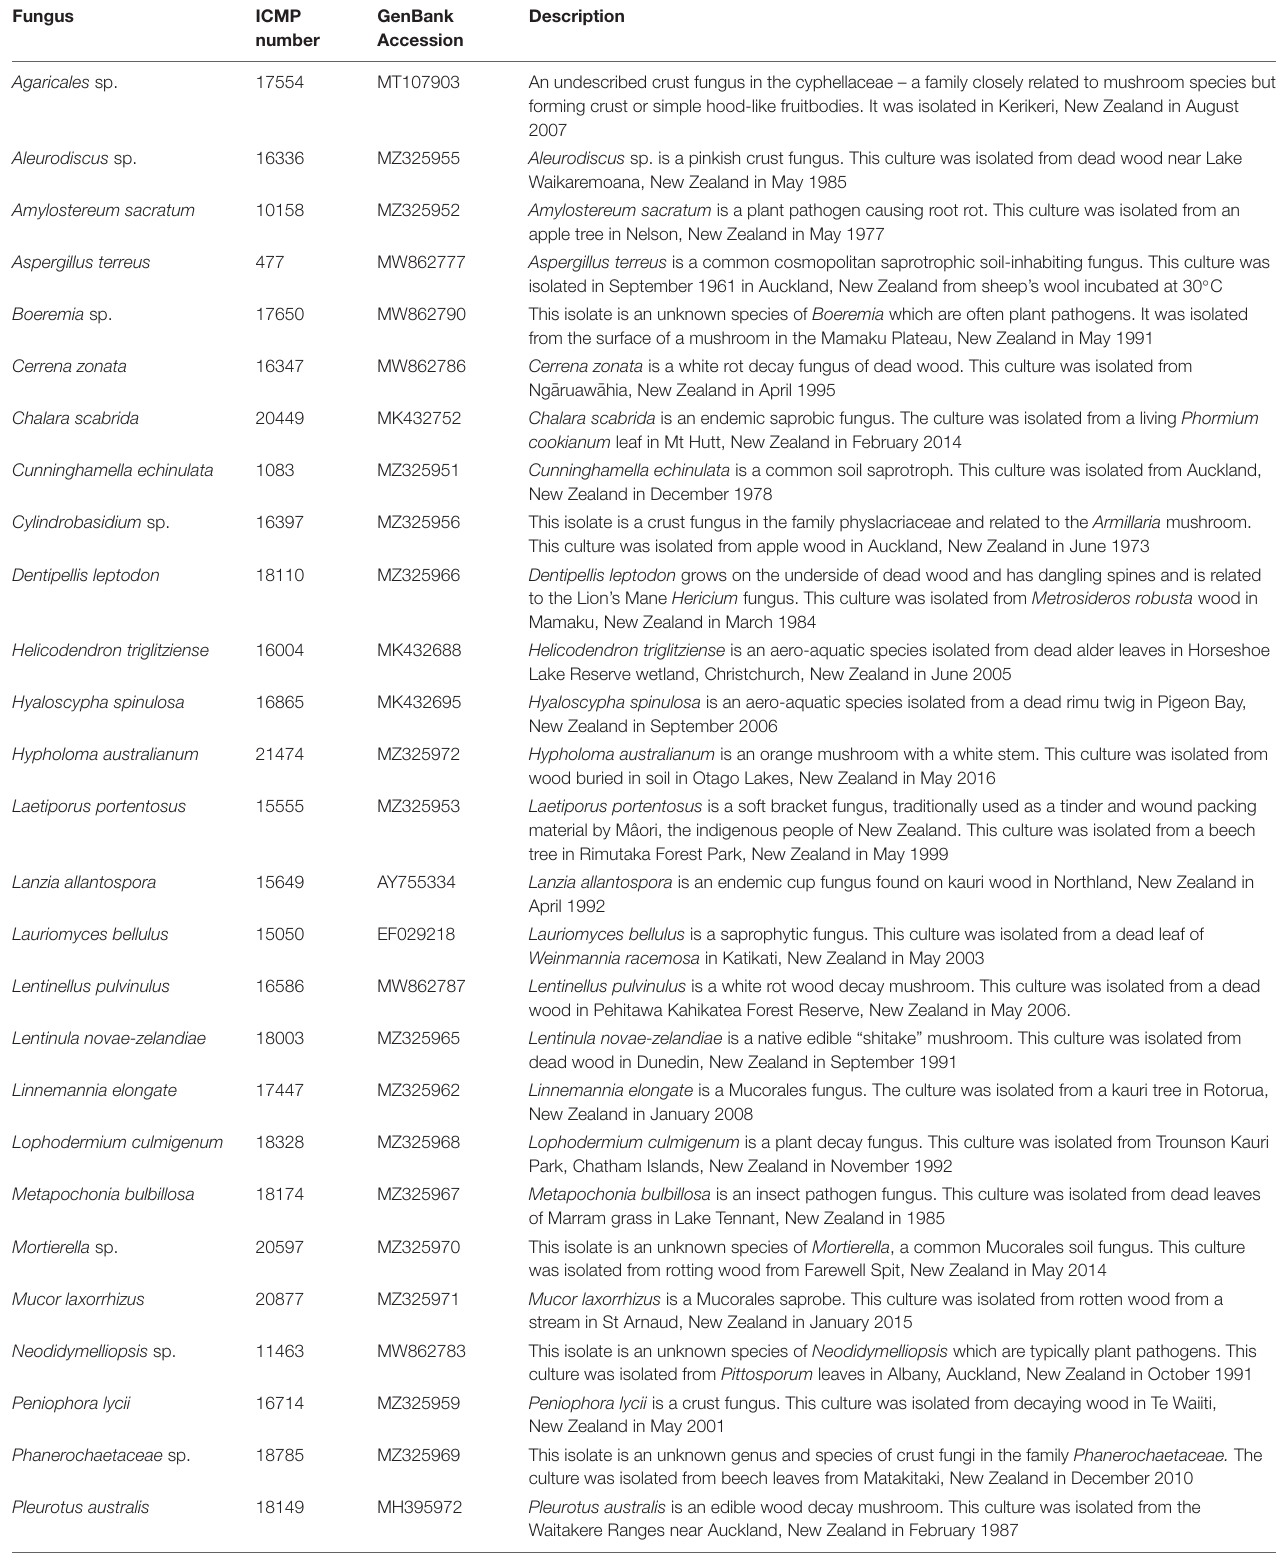
TABLE 1 | Fungal isolates used in this